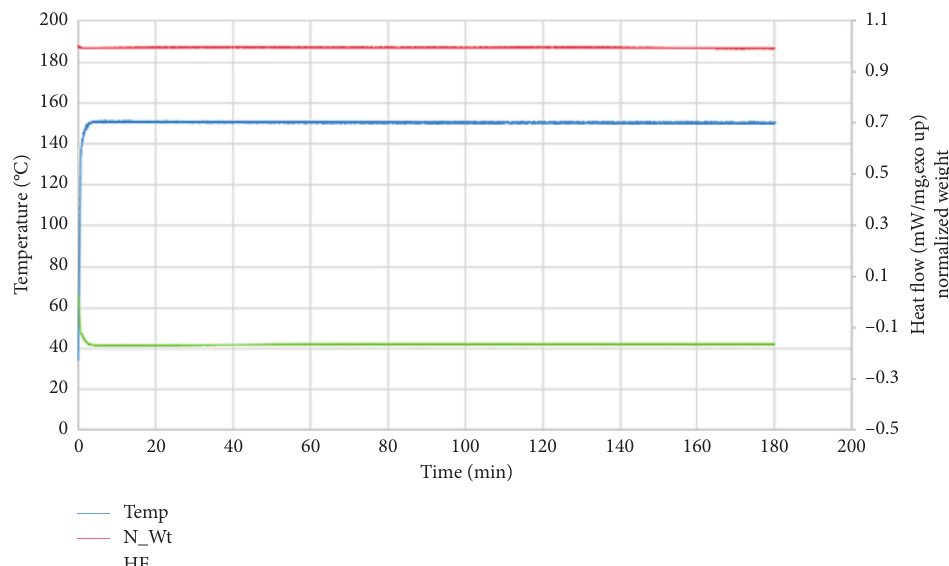
Figure 15: Heat flow, temperature, and normalized weight of chaulmoogra oil obtained from isothermal TGA in